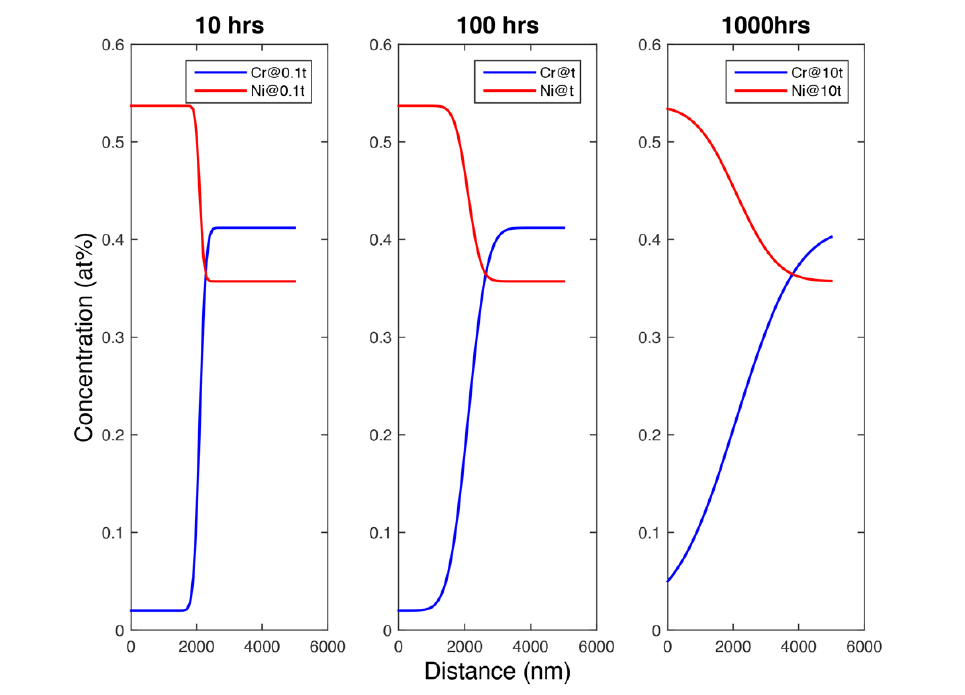
Figure 7 Diffusion profiles at varying times.